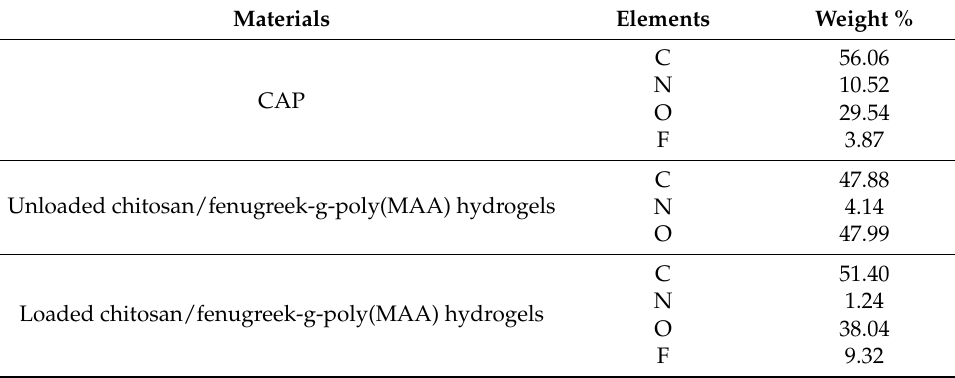
Figure 9. EDX spectra of ( a ) CAP, ( b ) unloaded, and ( c ) CAP-loaded chitosan/fenugreek-g-poly (MAA) hydrogels. Table 1. Elemental composition of the drug, unloaded hydrogels, and drug-loaded hydrogels.